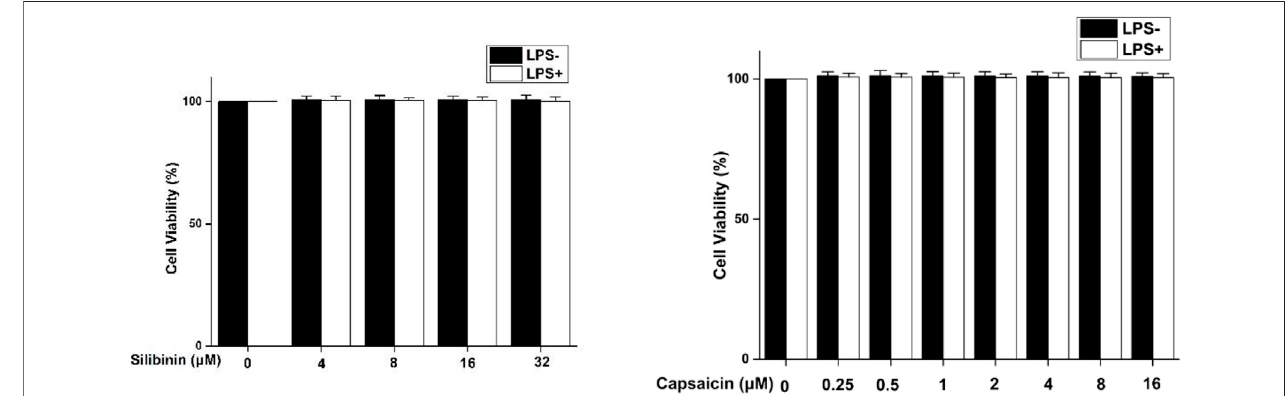
FIGURE 1 | Cytotoxicity of silibinin and capsaicin on RAW264.7 cells. RAW264.7 cells were seeded in 96-well plates and cultivated for 24 h. After silibinin and capsaicin with different concentrations were added for 2 h, the cells were treated with or without LPS (1 μ g/ml) for 24 h. To discard the medium, the MTT reagent was added , and incubated for 3 h. Formazan crystals were dissolved in 100 μ L of DMSO, and then absorbance at 490 nm was